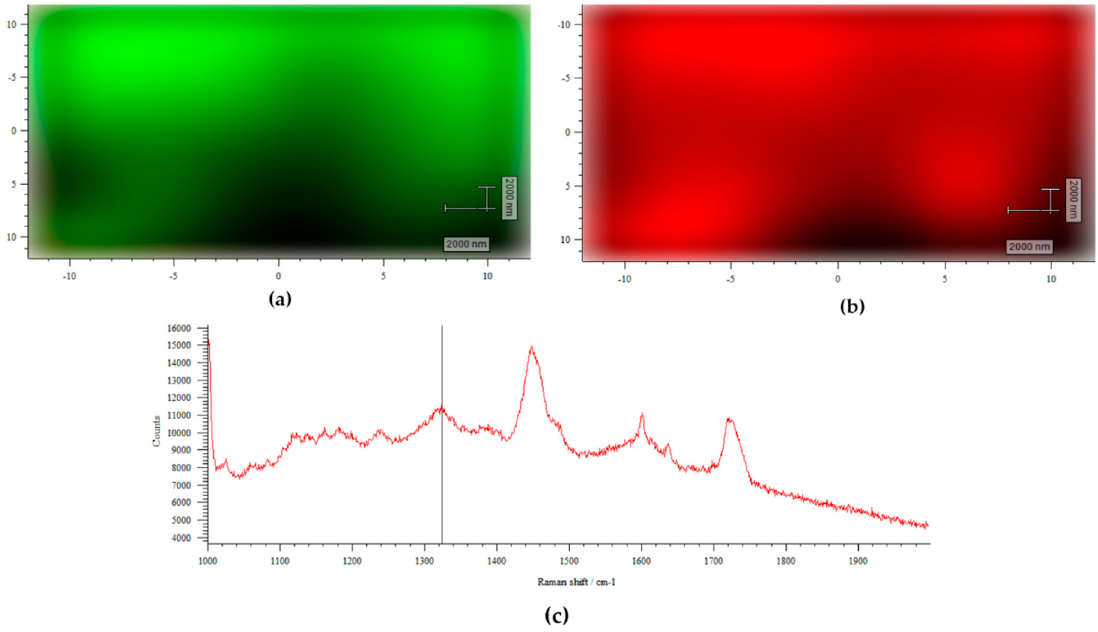
Figure 4. Raman surface mapping of ABC 0.3% GO. ( a ) Green corresponds to GO and black to ABC matrix; ( b ) red corresponds to ABC matrix and black to GO; and ( c ) Raman spectra to ABC 0.3% GO.